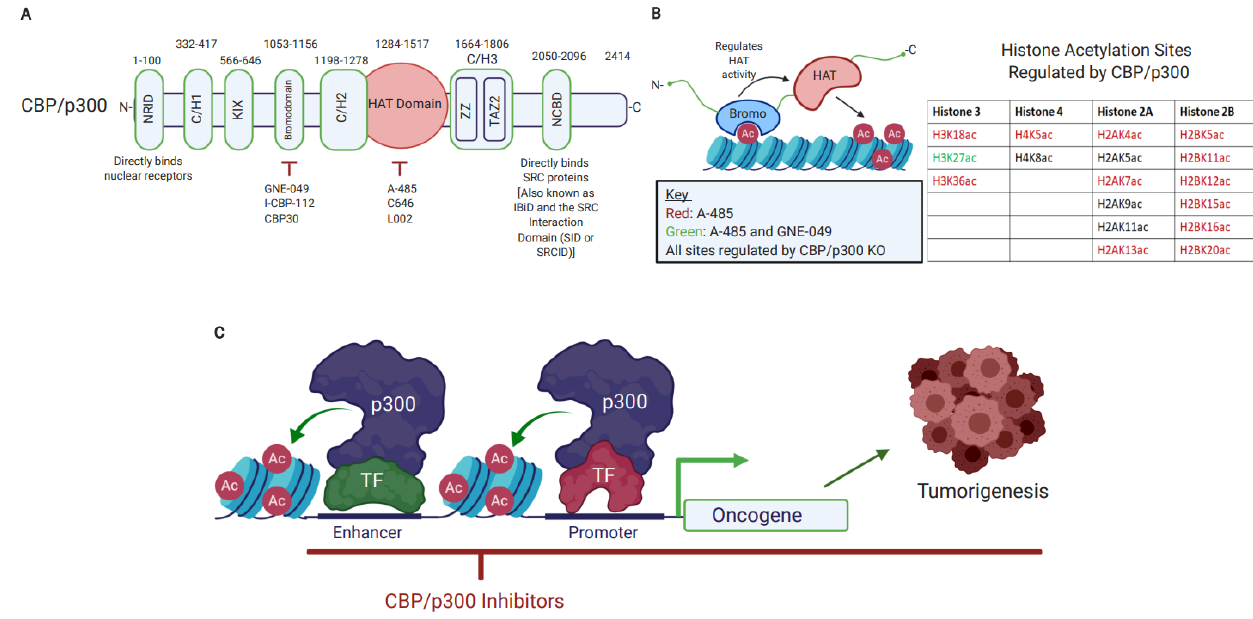
Figure 1. Structure and Function of acetyltransferases CBP/p300. ( A ) Structural modules of CBP/p300. Amino acid numbers are based on the p300 protein sequence. ( B ) Sites of histone acetylation catalyzed by CBP/p300 on the four core histones. All sites are regulated by CBP/p300; sites in red are downregulated by A-485 and sites in green are downregulated by both A-485 and GNE-049. ( C ) CBP/p300 function as co-activators of specific transcription factor. CBP/p300 inhibitors can reduce oncogene expression. Abbreviations: ac: acetylated lysine; Bromo: bromodomain; C/H1, C/H2 and C/H3: cysteine–histidine-rich regions 1, 2 and 3; NRID: the nuclear receptor interaction; HAT: histone acetyltransferase; IBiD: interferon-binding domain; KIX: a kinase-inducible CREB interaction region; NCBD: the nuclear co-activator-binding domain; SID/SRCID: steroid receptor co-activator protein-interaction domain; SRC: steroid receptor co-activator protein; TAZ: transcriptional adaptor zinc-binding domain; TF: transcription factor; ZZ: ZZ-type zinc